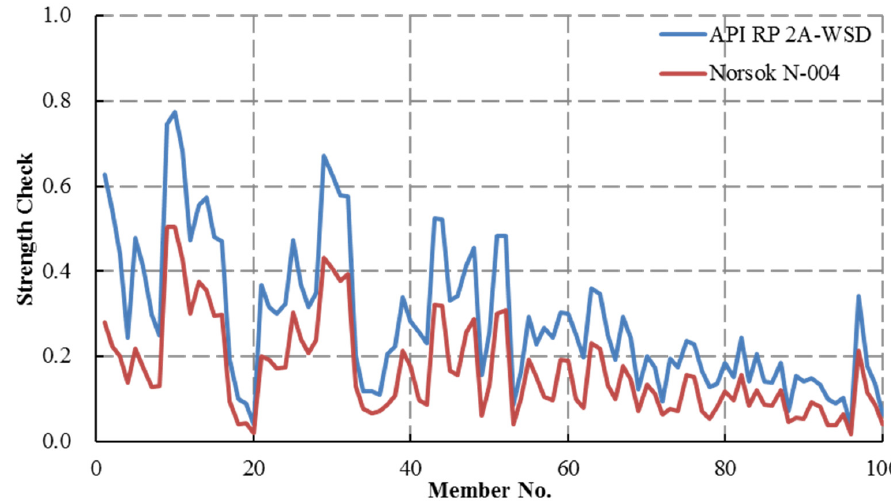
Figure 20. Member Strength Check (Case 2).